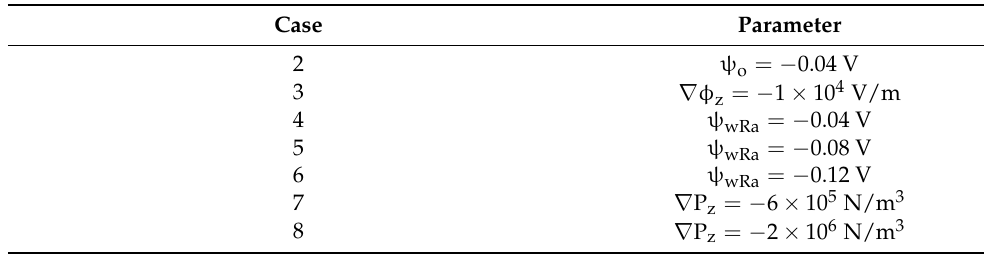
Table 5. Parameters that are different from the reference case. Porous cylindrical channel composed of two different materials.